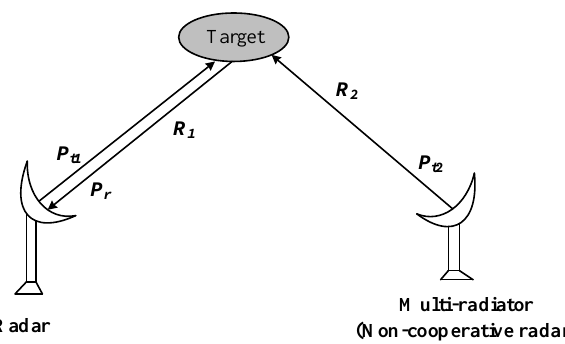
Figure 5. The incoherent and coherent situations of the external